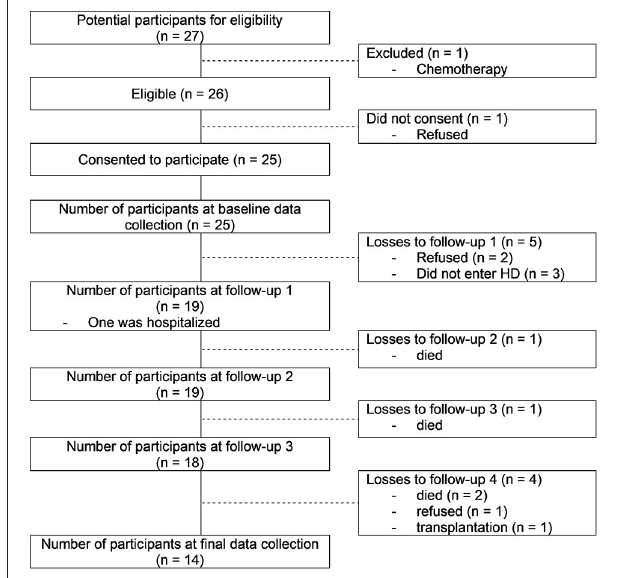
FIGURE 1 | Study flow